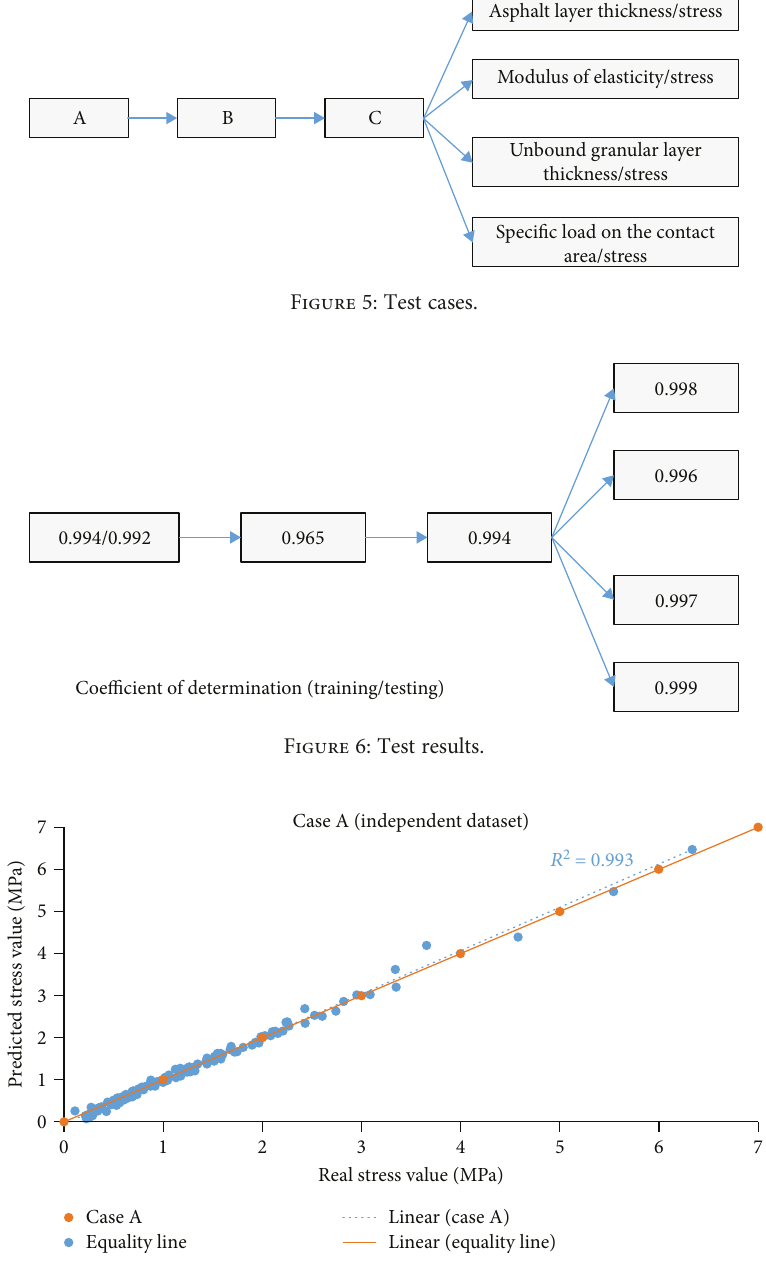
Figure 7: Results — case